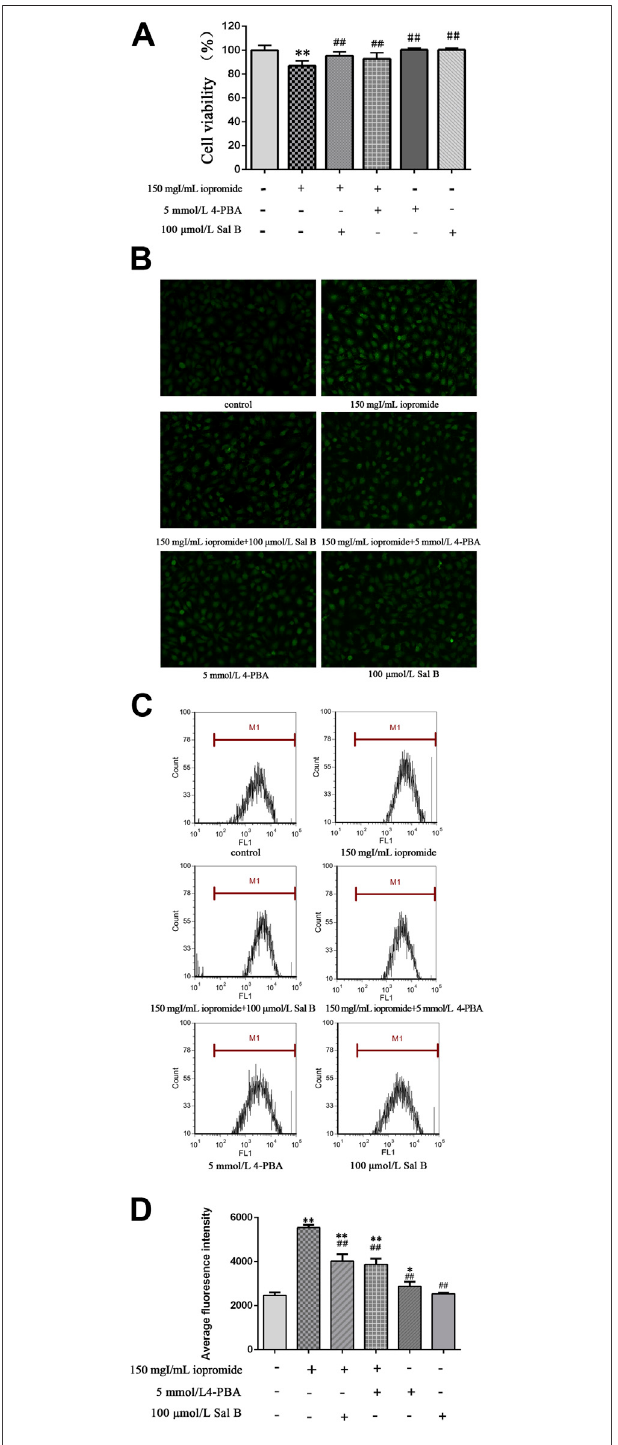
FIGURE 3 | Effect of Sal B or 4-PBA in iopromide-induced decrease in cell viability and ROS generation. (A) Compared with the iopromide-treated group, Sal B or 4-PBA alleviated the decrease in cell viability caused by iopromide.ThedataweredeterminedbyANOVAandLSDpost-hoctest andarepresentedasthemean ± SD(n (cid:1) 5).** P < 0.01vs.controlgroup; ## P < 0.01vs.Iopromidegroup. (B) Thegreen fl uorescence(readoutofROSlevel)in ( Continued )